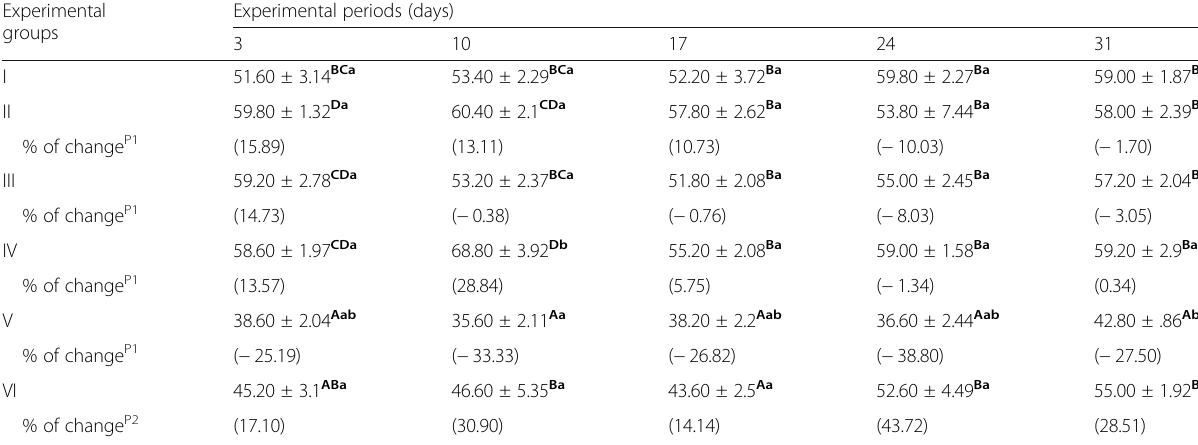
Table 8 Plasma levels of IL-2 (pg/ml) in the experimental groups at the experimental periods Experimental Experimental periods groups